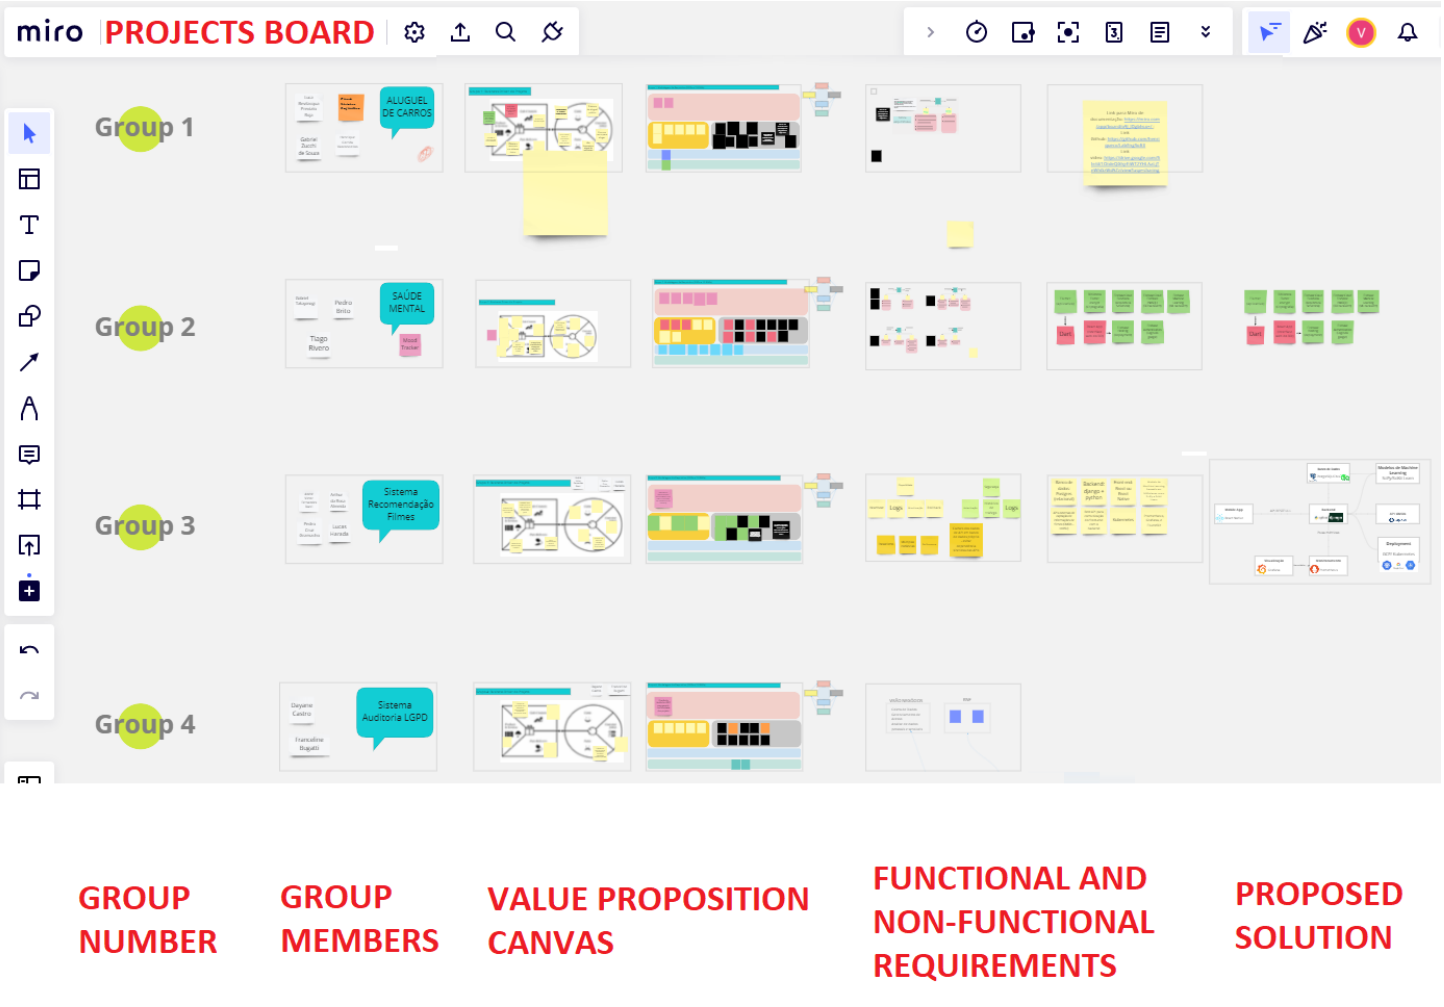
Figure 4. Example of using Miro in class for fifth-year Computer Engineering